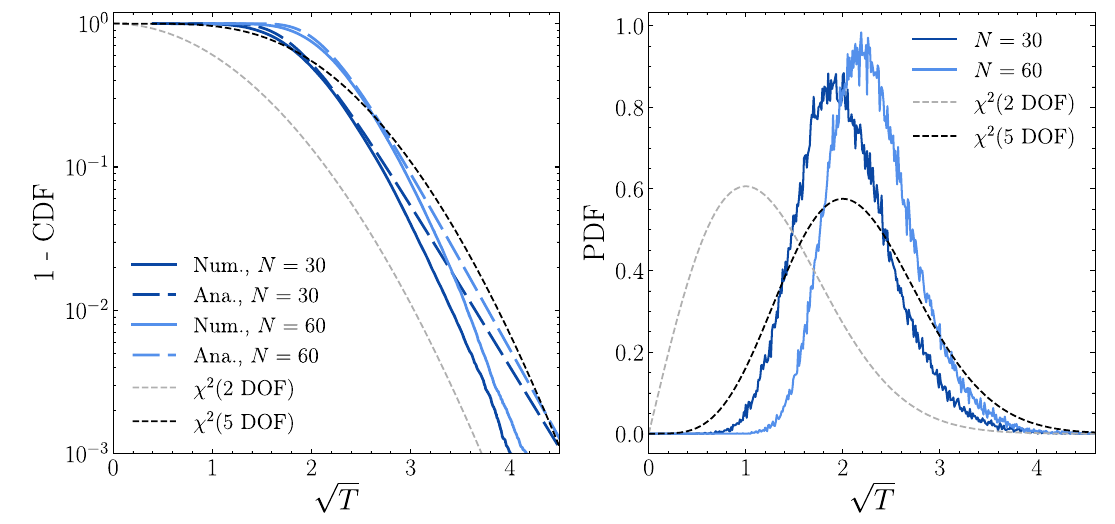
Fig. 1 Expected distribution for the square-root of the test statistic √ T = max κ ˜ a κ , where ˜ a κ are N standard normal random variables. The left panel shows 1-CDF, while the PDF is shown in the right panel. Dark (light) blue curves correspond to N = 30 ( 60 ) . Solid curves are